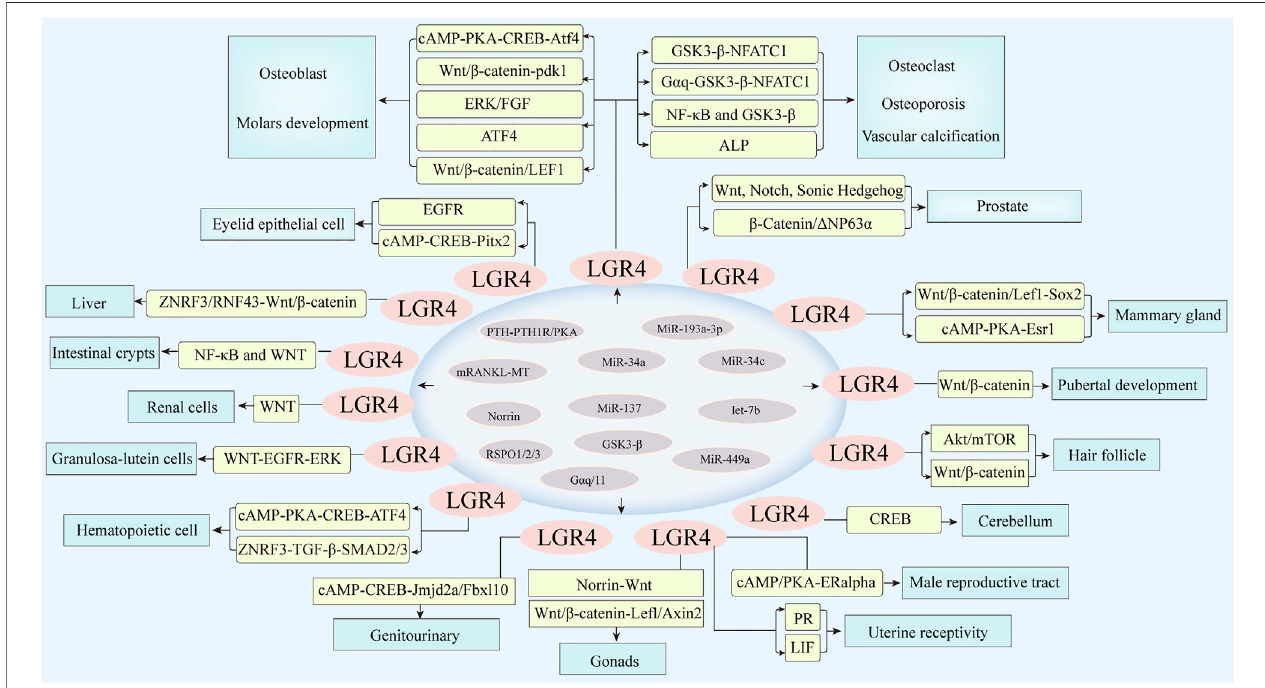
FIGURE 3 | LGR4 was expressed in multiple tissues involved in the regulation of cell differentiation and tissue development. MicroRNAs including miR-34a, miR- 34c, miR-193a-3p, miR-137, and miR-449a, let-7b could bind to the 3 ′ untranslated region of its target gene LGR4, resulting in its translational repression or degradation. Meanwhile, RSPO1/2/3, Norrin, and RANKL could act as ligands of LGR4. PTH-PTH1R/PKA, G α q/11, GSK3- β could also activate LGR4, which then stimulated corresponding molecules and induced downstream signaling, such as Wnt/ β -catenin, cAMP/PKA, Akt/mTOR, and so forth, thus regulating the differentiation of various organs.